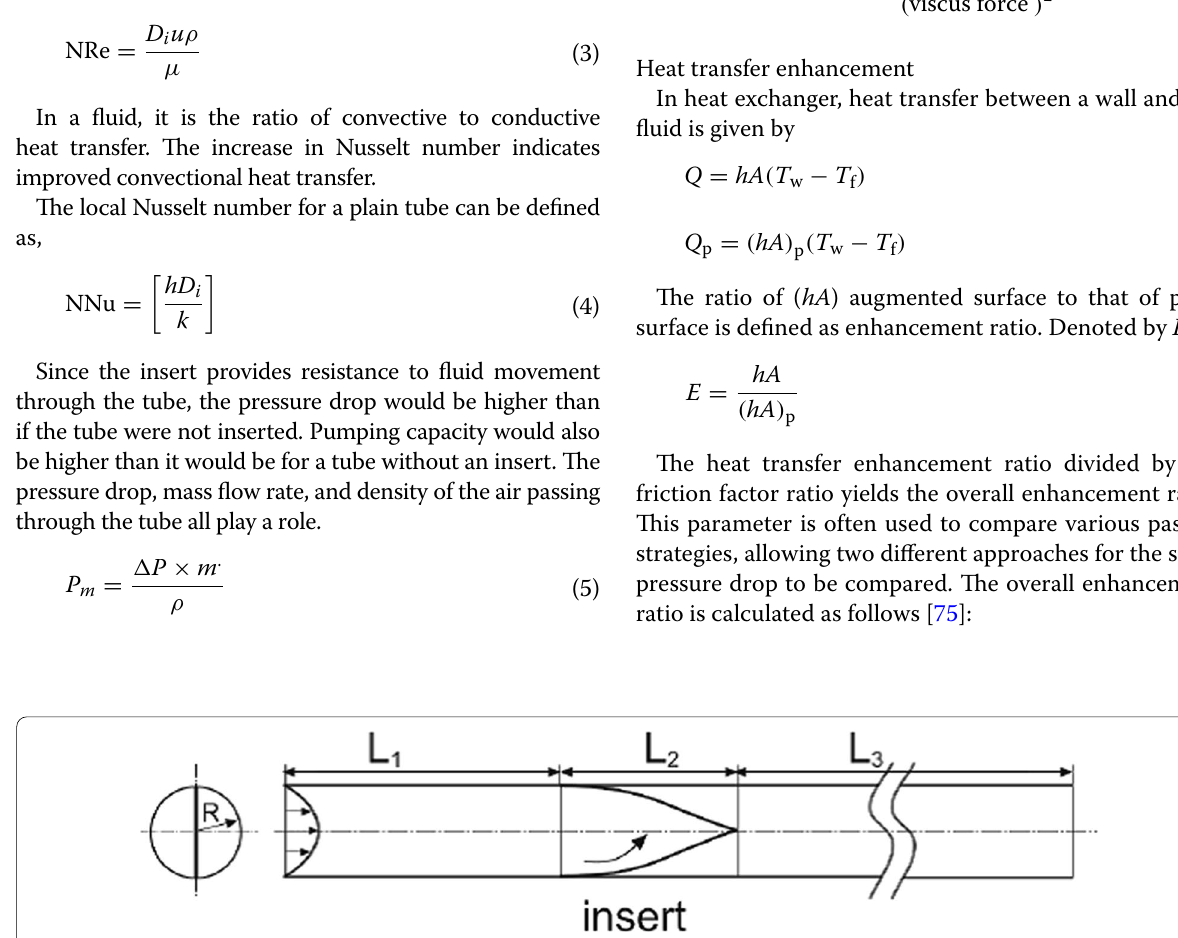
Fig. 8 Microfin structured tube with Twisted tape insert having 0.5 mm width